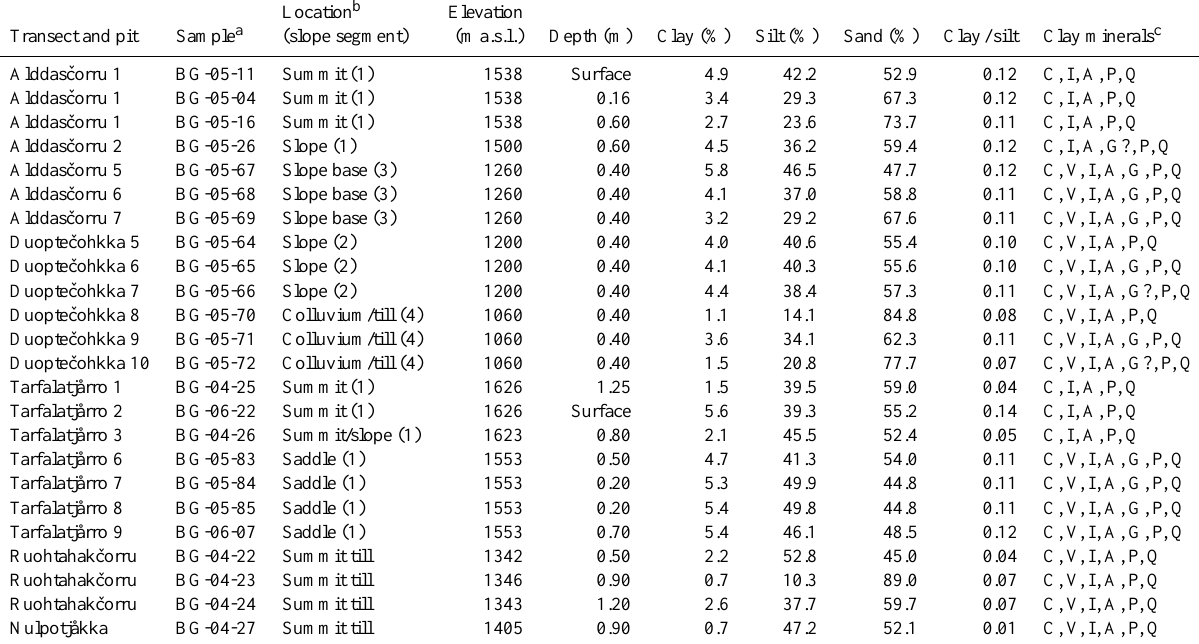
a BG-06-22 and BG-06-07 are representative of eight samples from Tarfalatjårro pit 2 and seven samples from Tarfalatjårro pit 9, respectively (Goodfellow et al., 2009). b Slope segments are numbered as follows: (1) diffusion-dominated summit, (2) solifluction-dominated slope, (3) steep mass wasting, (4) concave depositional, where regolith comprises colluvium and till. Till is indicated by the presence of clasts of different lithologies and a high abundance of fine matrix. c C – chlorite; V – vermiculite; I – illite; A – amphibole; G – gibbsite (? indicates uncertain); P – plagioclase (dominant feldspar); Q –